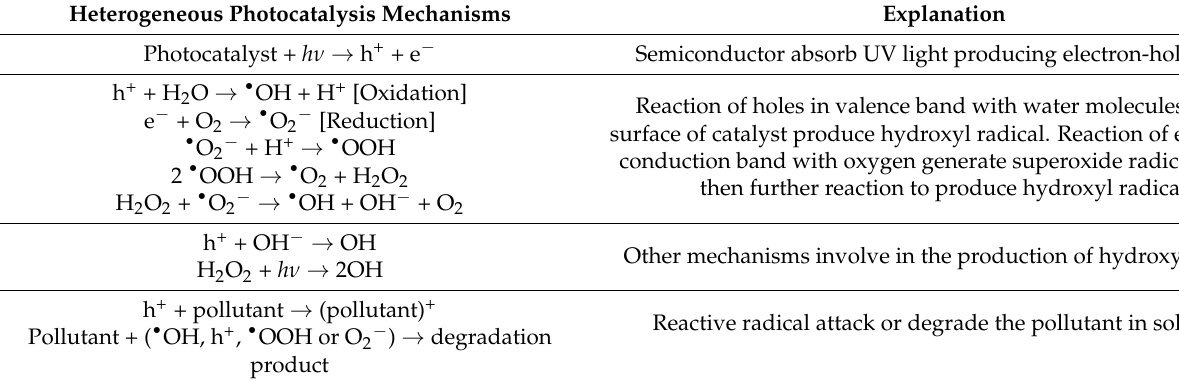
Table 6. Chemical reaction of heterogeneous photocatalysis reaction [40,41]. Heterogeneous Photocatalysis Mechanisms